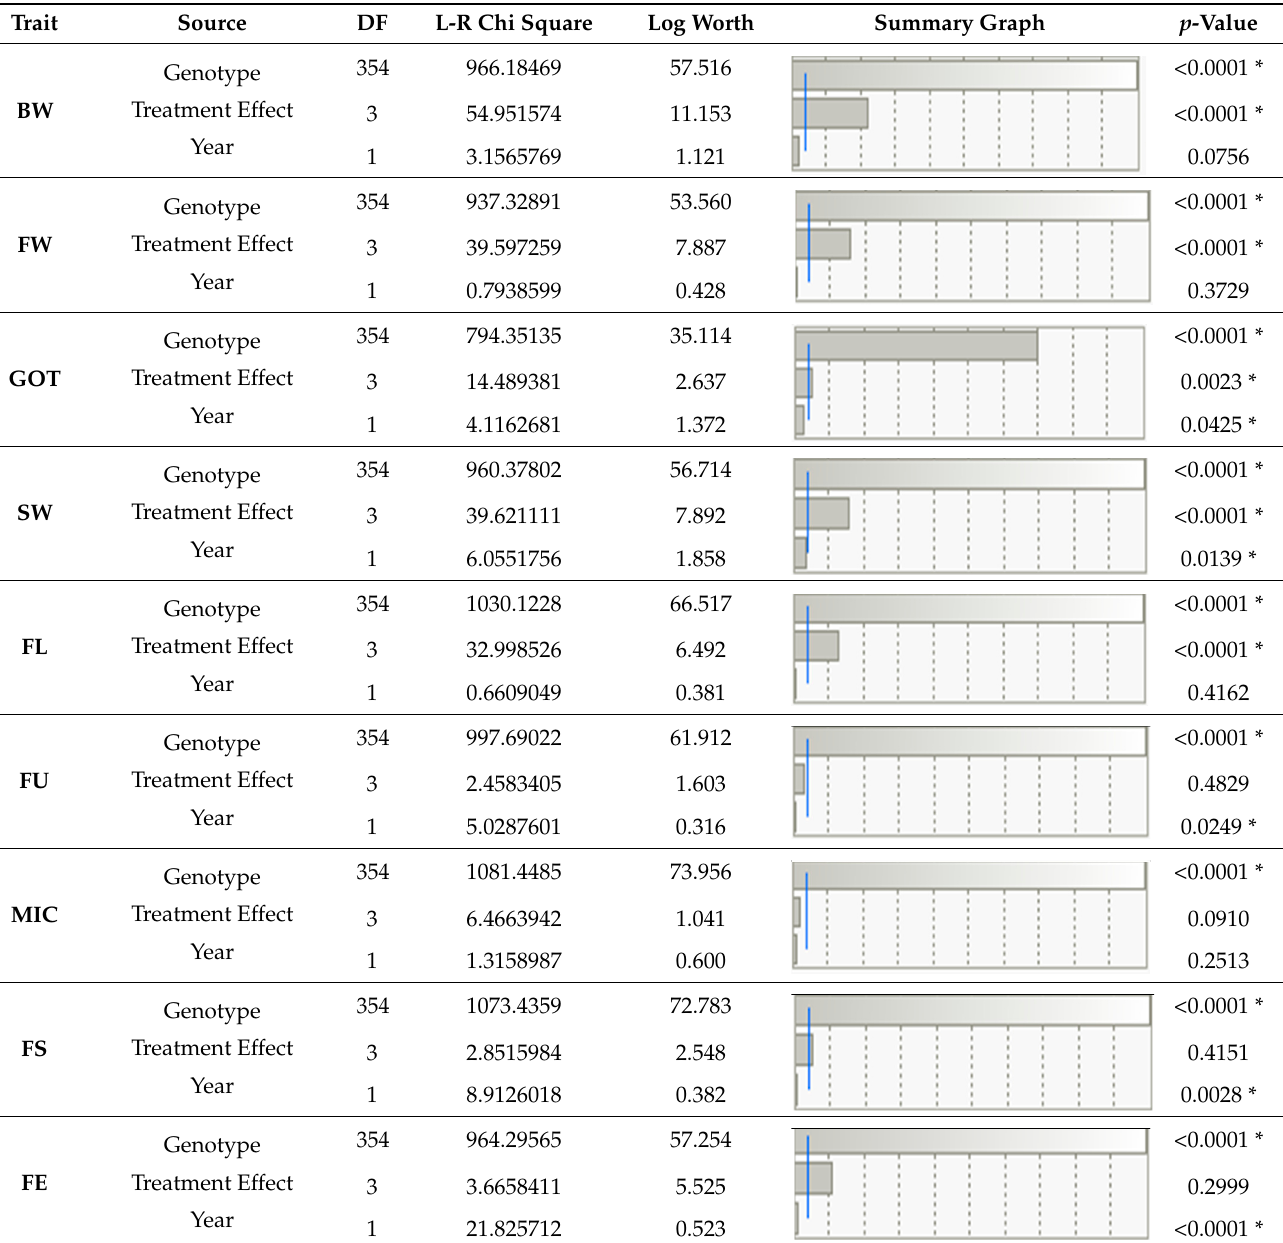
Table 2. Analysis of variance (ANOVA) using the generalized linear model for the source-sink effect (E1–E4) across 2 years 2018 and 2019.